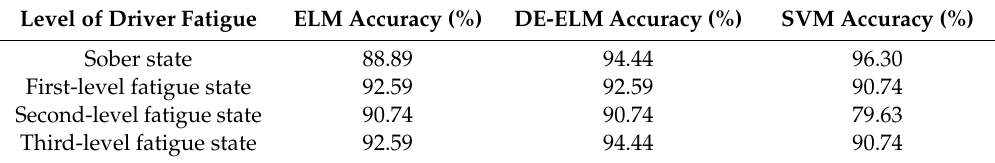
Figure 14. SVM-based fatigue state detection results. Table 3. Classification accuracy of ELM, DE-ELM (200 nodes) and SVM for each